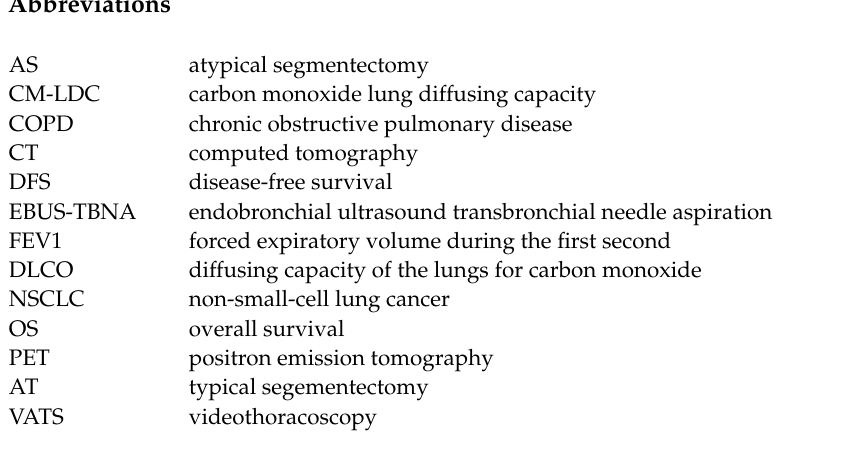
lobectomy and the two types of segmentectomy in stage IA (A) and IB diseases (B), respectively; Table S1. Distribution of the resected lobes and segments. RUP= right upper lobe, LUL= left upper lobe, RML= right medial lobe, RLL = right lower lobe, LLL = left lower lobe; Table S2. Preoperative functional data and data regarding resected lymphnodes Pres = pre-surgey; pps = predicted post operative; Table S3. Detailed data regarding surgical margins; Table S4. Data regarding tumor relapse after the three different surgical